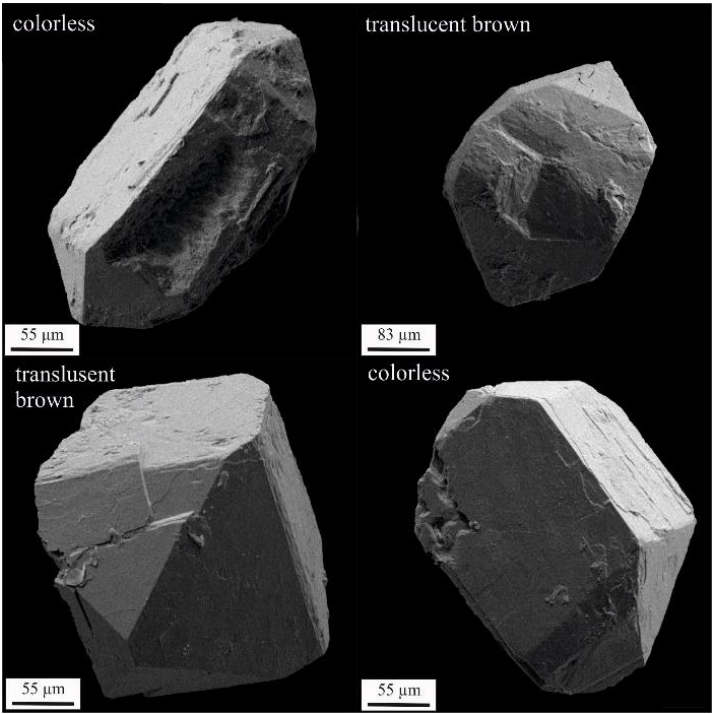
Figure 5. Photomicrography of selected zircon crystals from melanocratic foyaite (sample 73–99). The morphology of zircon grains is defined by the combination of a dipyramid and a prism, which indicates their magmatic origin.